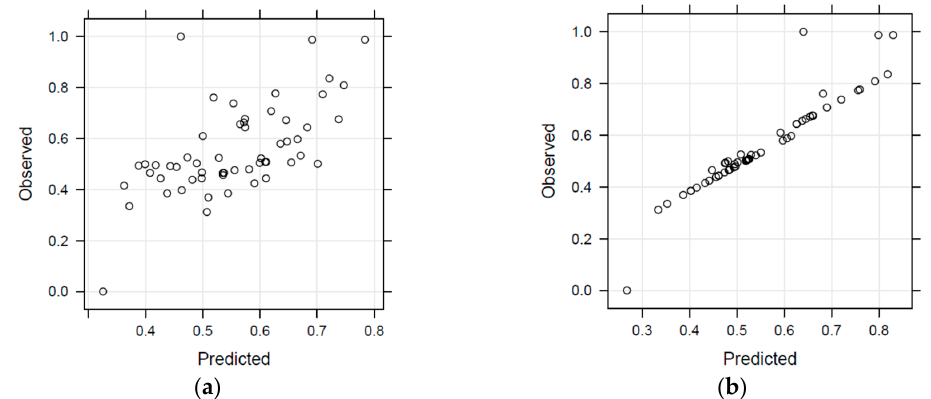
Figure 4. Correlation of real and predicted values of HHV during the training stage in two cases: ( a ) LR and ( b ) SVM (RBF kernel).